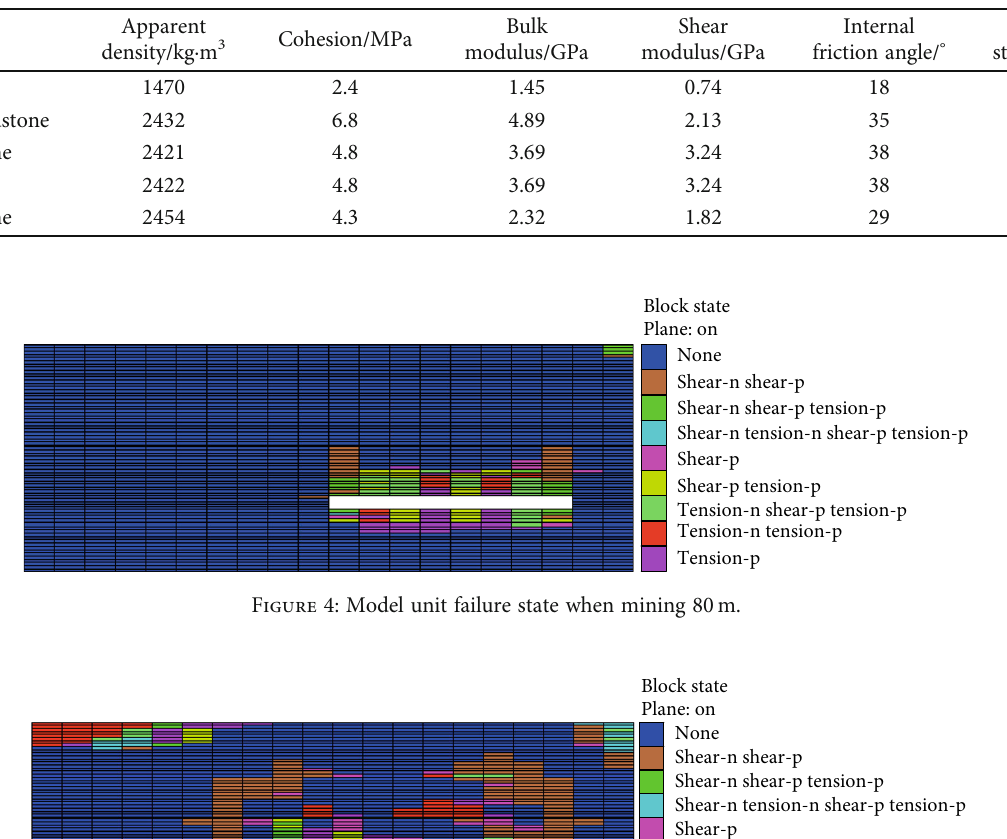
Table 2: Physical and mechanical parameters of rock